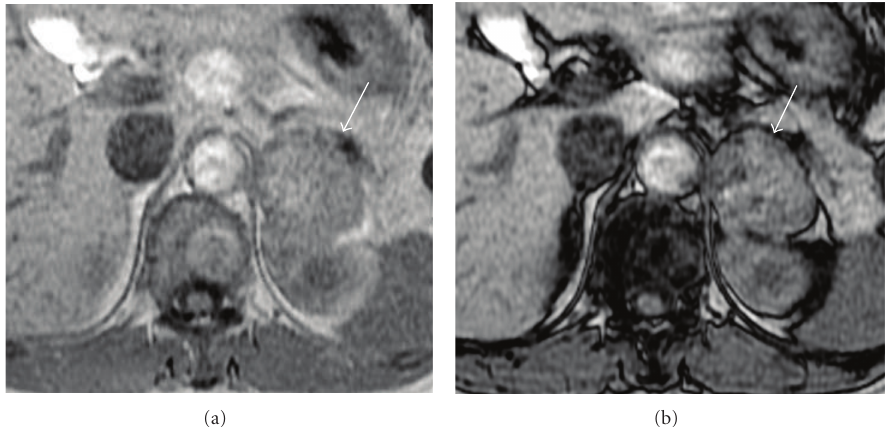
Figure 1: In-phase gradient echo MRI demonstrated a 40 mm, well-defined left adrenal mass (a) (arrow). Opposed-phase imaging showed signal decrease in part of the mass (b), indicating lipid content.